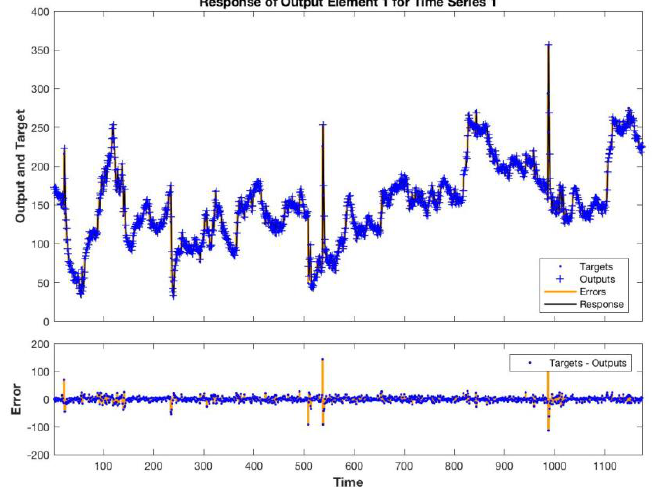
Figure 7. Estimated and measured total VOCs.